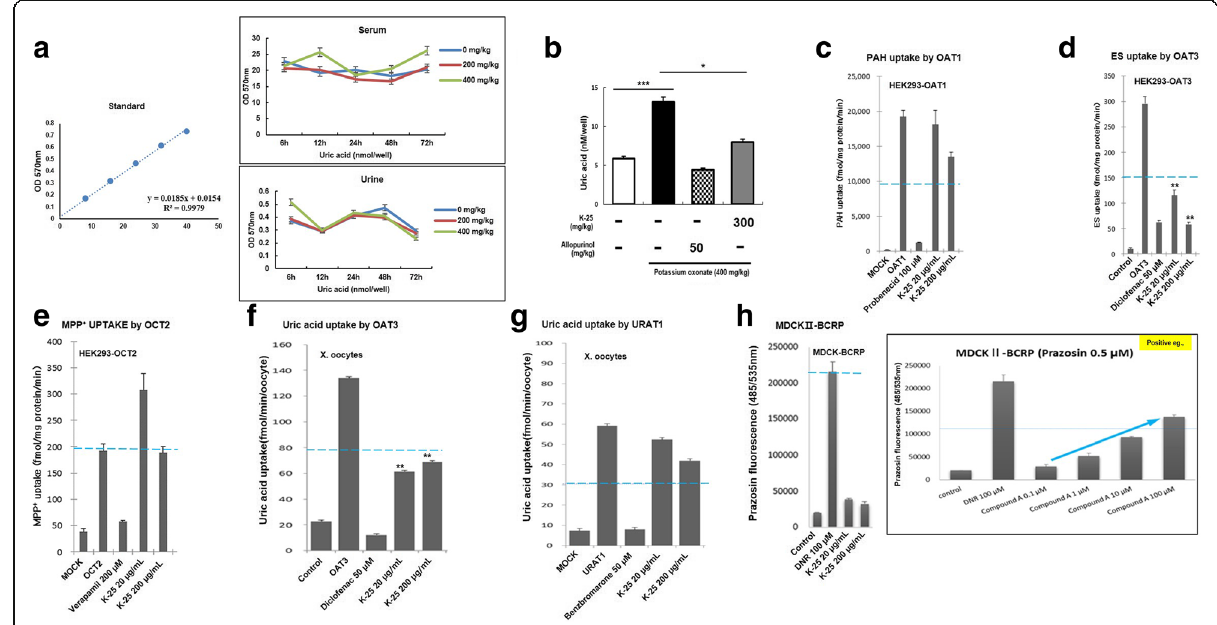
Fig. 1 Inhibition of uric acid and transporters by K-25 in vivo model. a In vivo uric acid level was determined using the uric acid assay kit. Uric acid detection analyses showed urine and serum levels of uric acid at 6 – 72h after PO injection in different groups of mice as indicated. Concentration of PO: 0mg/mL (blue line), 200mg/mL (red line), 400mg/mL (green line). b Effects of K-25 on serum in hyperuricemia mice. Mice were pretreated with 400mg/mL of PO for 3days prior to 300mg/mL of K-25 treatment for 72h. Values are mean±standard error of the mean. ** p <0.01, compared to the PO-treated control. The specific substrates used were ( c ) [ 3 H]PAH for OAT1, ( d ) [ 3 H]ES for OAT3, and ( e ) [ 3 H]MPP + for OCT2 in the HEK293 overexpressing system. ( f , g ) Inhibitory effect of K-25 on uric acid uptake by OAT1 and URAT1 transporters in Xenopus oocytes. h Transcellular transport of prototypical substrates of BCRP was measured using monolayers of MDCK cells transfected with the MDCK genes, or of MDCK-WT control cells seeded on transwell membranes. Prazosin (2 μ M), a substrate of BCRP was incubated with the MDCK-BCRP cell lines. All values are mean±SD (triplicate in each experiment; each experiment was repeated three times). ** p <0.01, compared to OAT3. The statistical significance (* p <0.05, ** p < 0.01, *** p <0.001) was determined using an one-way analysis of variance (ANOVA) with Bonferroni